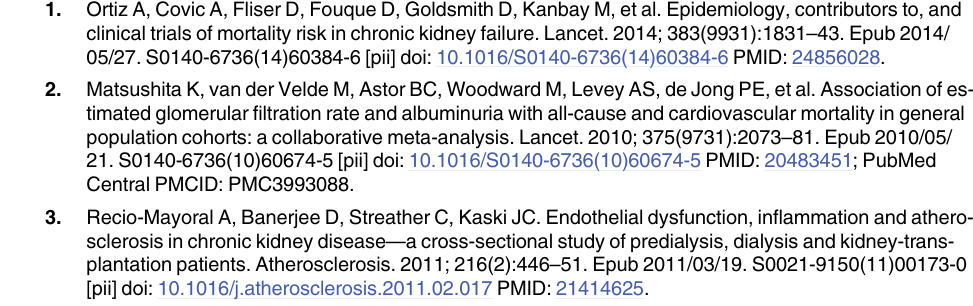
S1 Fig. c-IMT measurements, fasting glucose levels and VCAM-1 protein levels. Relation- ship between c-IMT measurements, fasting glucose levels and VCAM-1 protein levels in the ar- tery wall at baseline (A and B) and at the first post-transplant year (C and D). (TIFF) S2 Fig. Overall Kaplan-Meier curves according to baseline c-IMT tertiles. Log-rank analysis 7.3, P = 0.025. Log-rank test for comparison of survival between c-IMT tertiles (T3 vs. T1, P = 0.006; T2 vs. T1, P = 0.068; T3 vs. T2, P = 0.309). S3 Fig. Overall Kaplan-Meier curves according to VCAM-1 protein tertiles. Log-rank analy- sis 4.8, P = 0.089. Log-rank test for comparison of survival between VCAM-1 tertiles (T3 vs. T1, P = 0.035; T2 vs. T1, P = 0.202; T3 vs. T2, P =